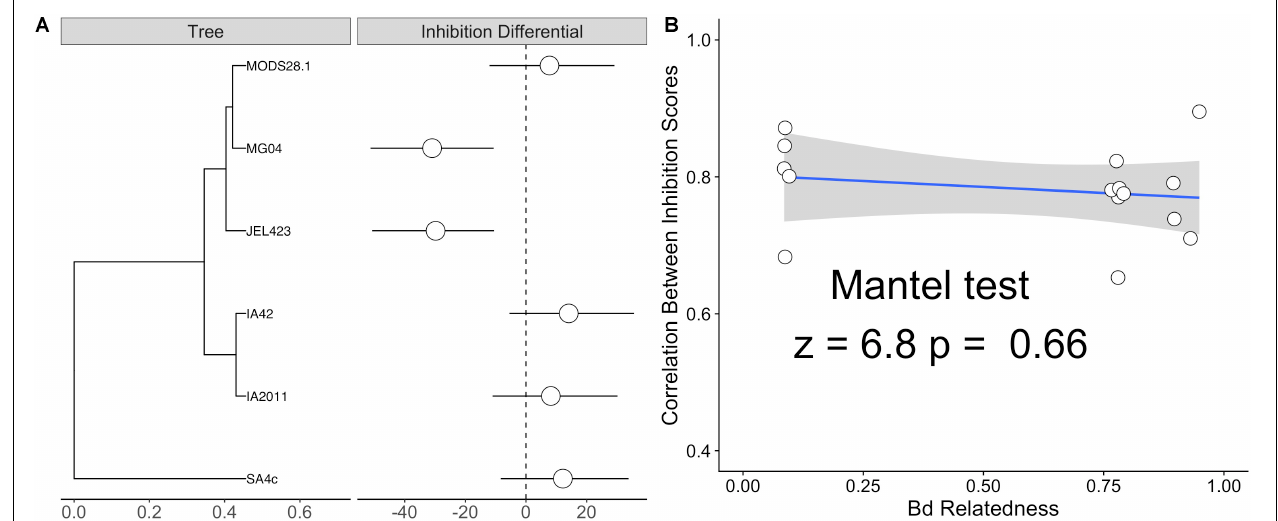
FIGURE 3 | (A) Phylogenetic tree of six sequenced Bd isolates alongside isolate-specific inhibition differential – defined as the departure from the global mean inhibition value from a Bayesian linear mixed effects model (LMM) with a Bd random effect. Estimates are marginalized with respect to bacterial genus of probiotic isolates. Both JEL423 and MG04 exhibit 95% credible intervals not crossing zero, indicative of lower average inhibition potential compared to other isolates. (B) Correlation plot between the average pairwise relatedness between Bd isolates and the correlation between their inhibition scores for the panel of tested probiotics (listed in Figure 2 ). A Mantel test indicated no obvious relationship between inter-isolate genetic distance and similarity of inhibition profiles ( p = 0.6).